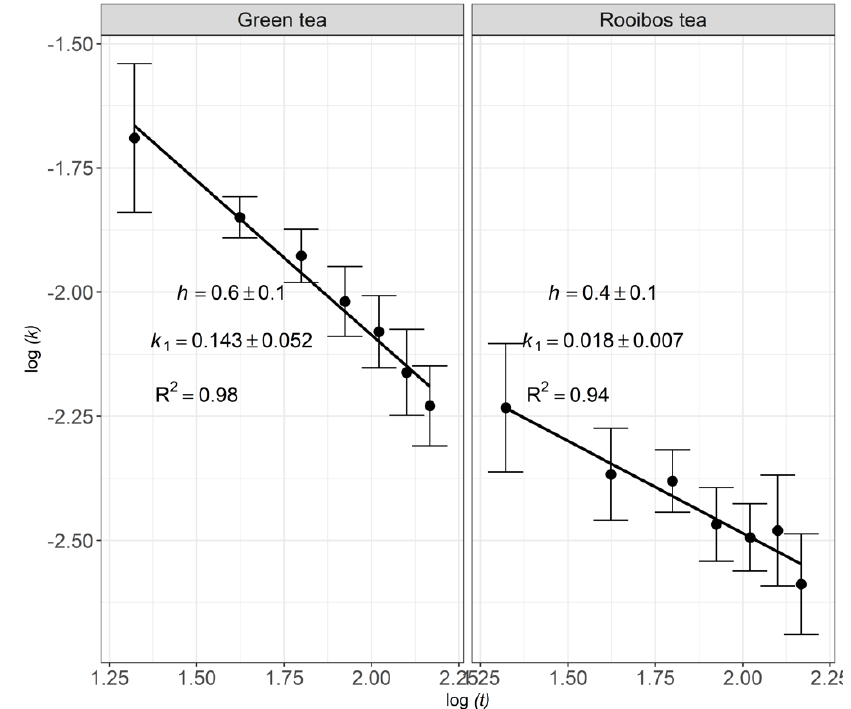
Figure 6. First order kinetics of teas and cranberry litter under field conditions.